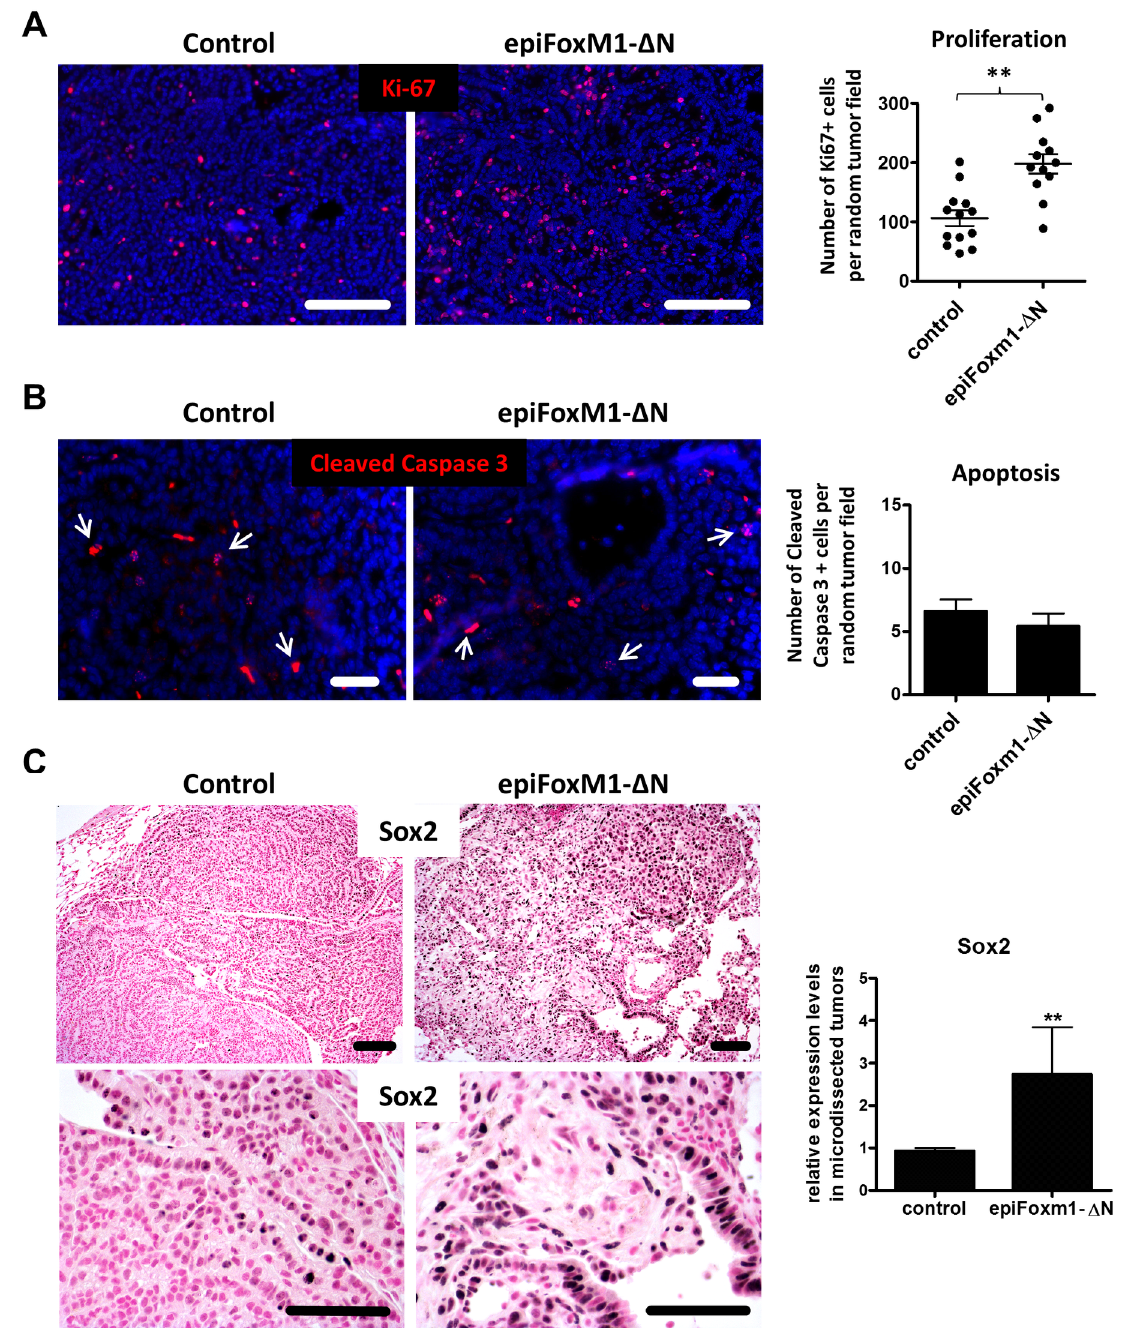
Fig 3. FOXM1 increasescellular proliferation in epiFoxM1- Δ N tumors. (A) Increasednumber of Ki67-positive cells in epiFoxM1- Δ N tumors is shown by immuno staining(left panels). Numbers of Ki67-positive cells were counted in ten random fields of control and epiFoxM1- Δ N tumors at 200x magnification (right graph). (B) No changesin apoptosiswere found in epiFoxM1- Δ N tumors comparedto controls. Tumors were stainedwith antibodies specific to cleavedcaspase 3 (arrows, left panels)and the number of positive cells were counted(right graph). The numberof cleavedcaspase 3-positive cells was countedusing ten random fields at 200x magnification. (C) Expression of FOXM1 in lung adenomas increasedthe numberof SOX2-positive cells. The increasedSOX2 protein is shownwith immunohistochemistry using antibodiesagainstSOX2 (left panels). Increased Sox2 mRNA is demonstrated by qRT-PCR (right graph). β -actin mRNA was used for normalization. A p- value < 0.01 is marked with a doubleasterik ( **